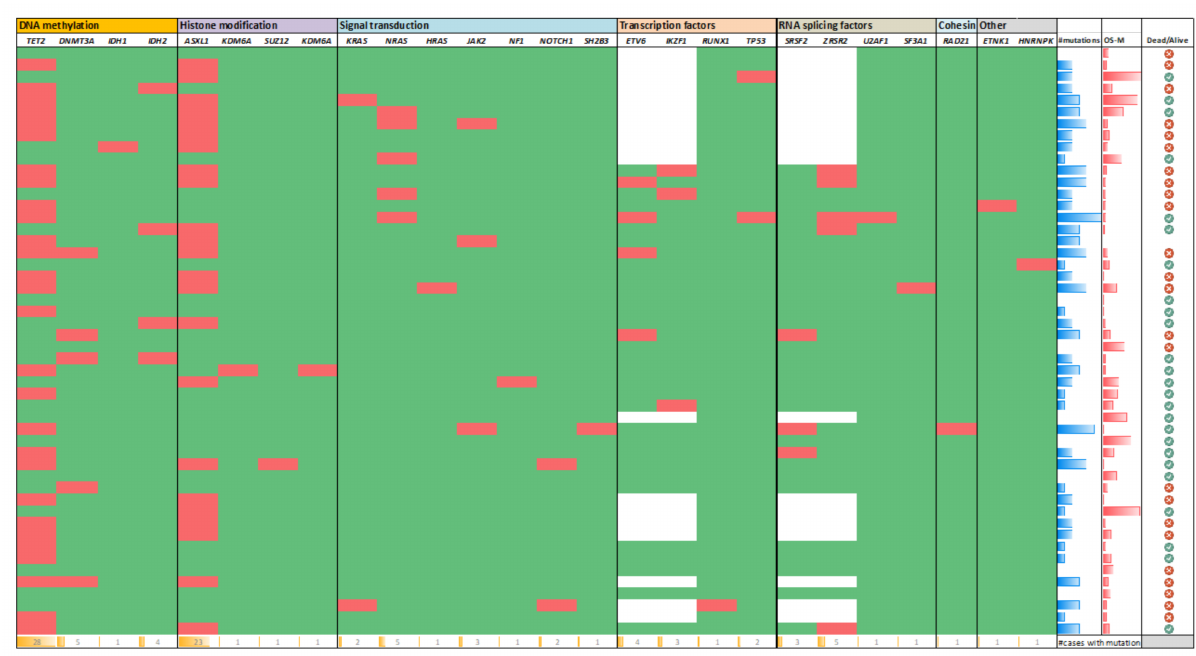
Figure 2. Somatic mutation landscape of blastic plasmacytoid dendritic cell